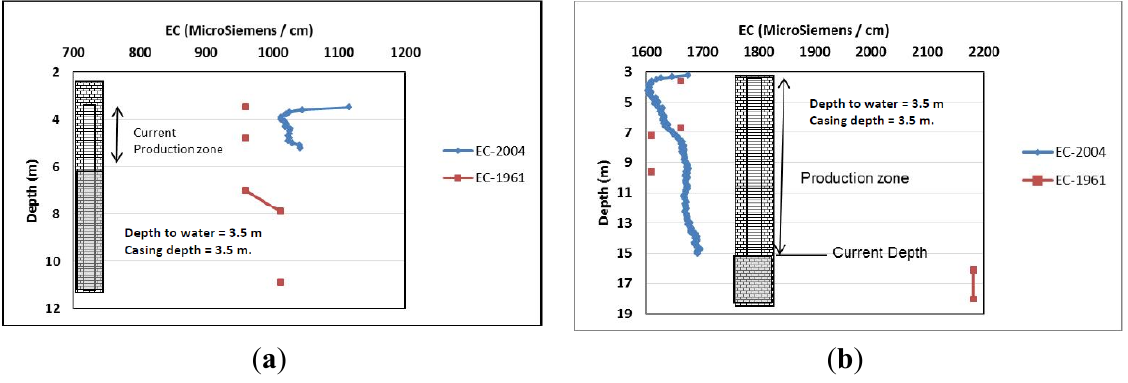
Figure 7. Salinity Stratification influenced by evaporation in QL aquifer ( a ) ULE099 and ( b )